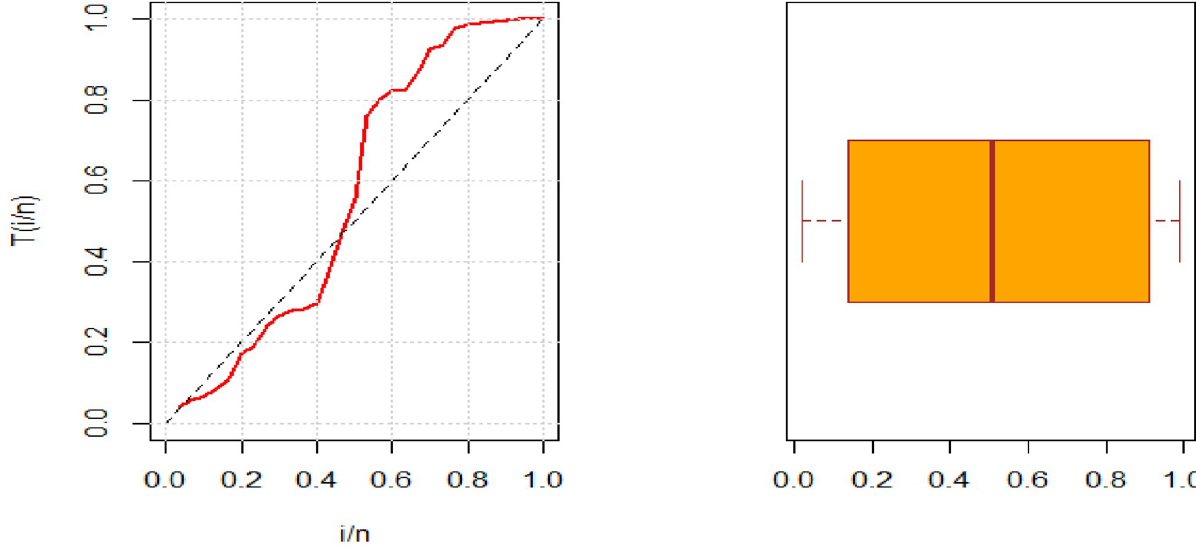
Fig 3. Boxplot and TTT plots for both